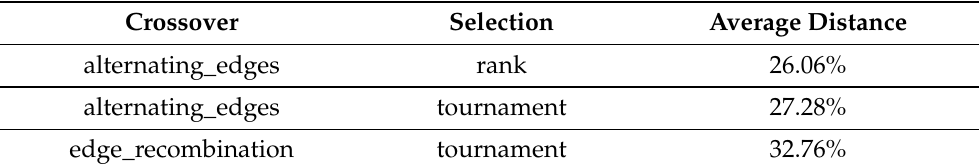
Table 6. Crossover domination experiment—averaged results from all instances, grouped by crossover and selection.